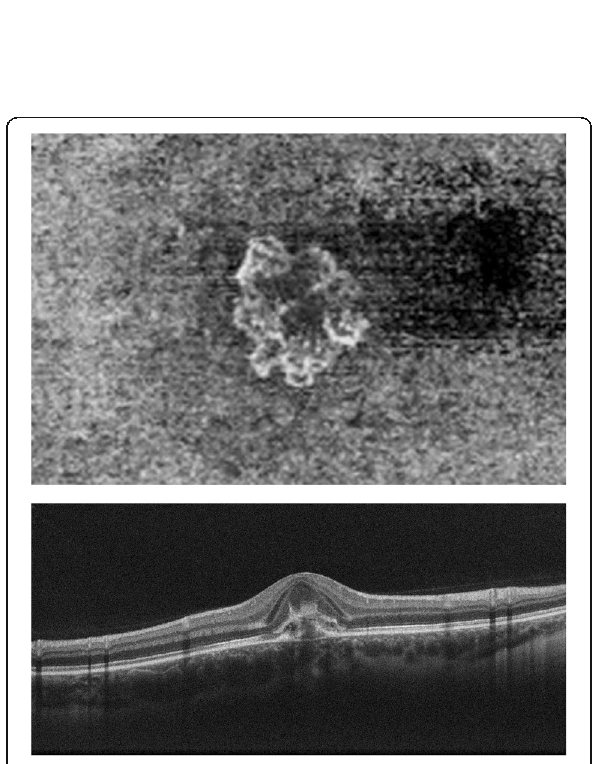
Fig. 8 Multifocal choroiditis (MFC), OCT-A. Neovascular net clearly shown by en face OCT-A (top) and